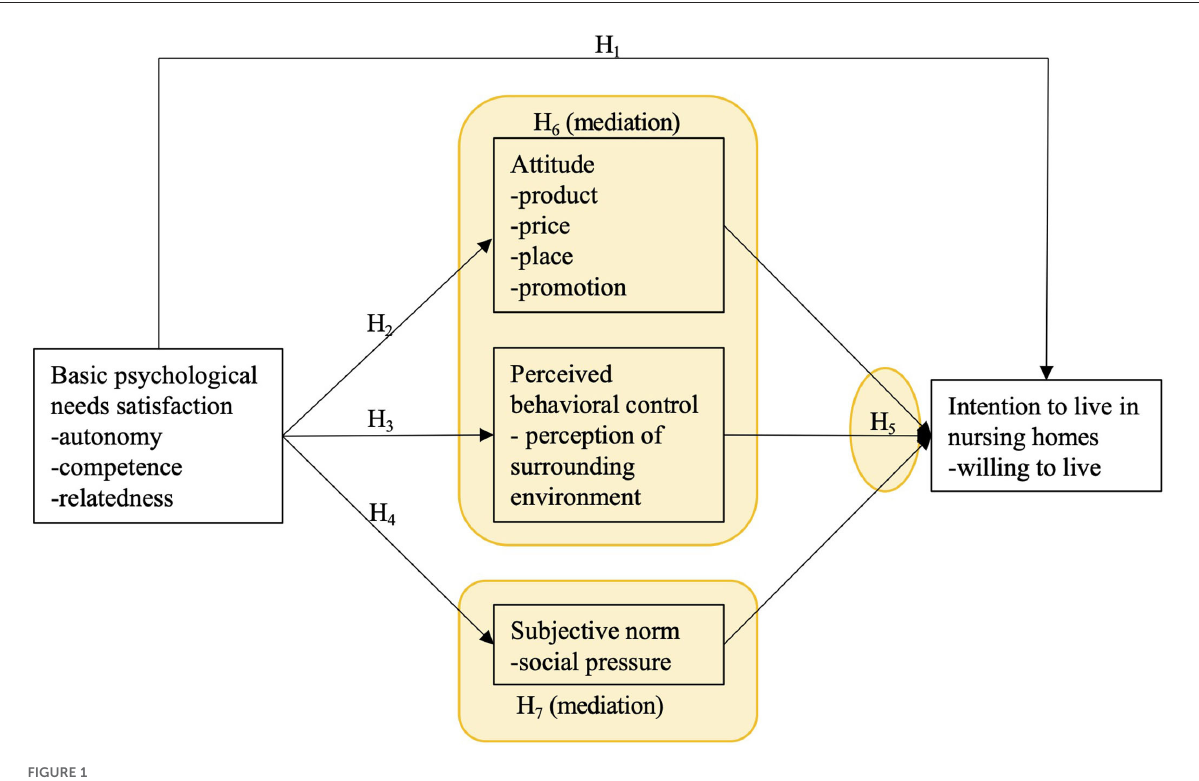
FIGURE1 Framework